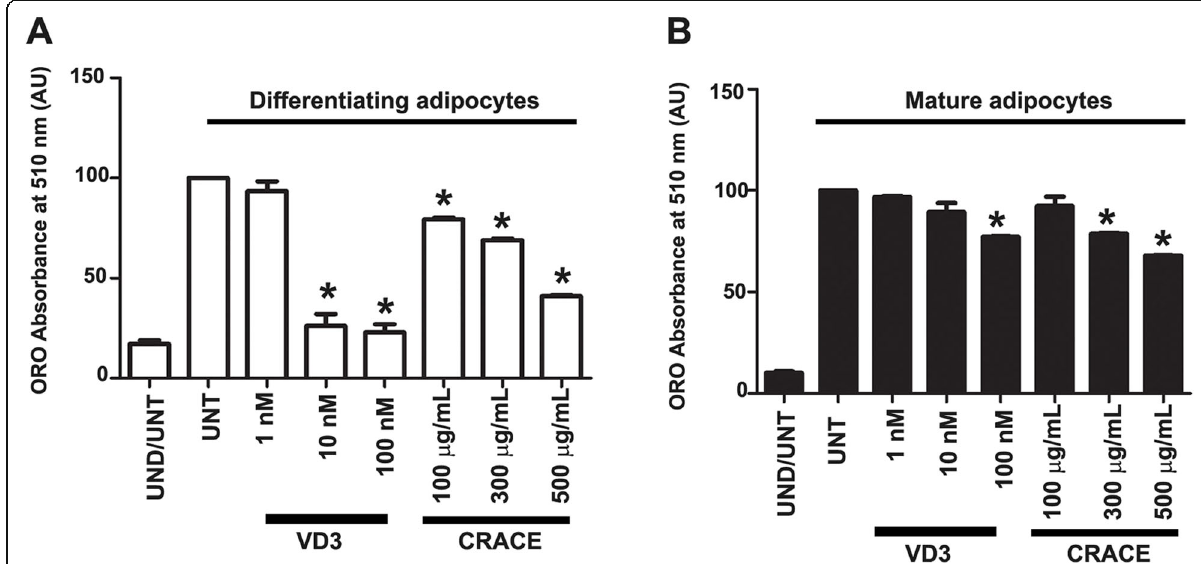
Fig. 6 Comparison of anti-adipogenic activity of CRACE and pure 1 α , 25-dihydroxy vitamin D3. a . Inhibition of preadipocyte differentiation by different doses of CRACE and 1 α , 25-dihydroxy vitamin D3 (VD3). b . Treatment of differentiated mature adipocytes with different doses of CRACE and 1 α , 25-dihydroxy vitamin D3 reduced lipid accumulation in these cells. In both the experiments 500 μ g/mL CRACE had similar effect that of 100 nM pure 1 α , 25-dihydroxy vitamin D3. Bars represent mean ± SEM, n = 3. One-way ANOVA followed by Bonferroni post-test was performed to evaluate the statistical significance. * indicates p < 0.05 for induced-untreated (UNT) vs.